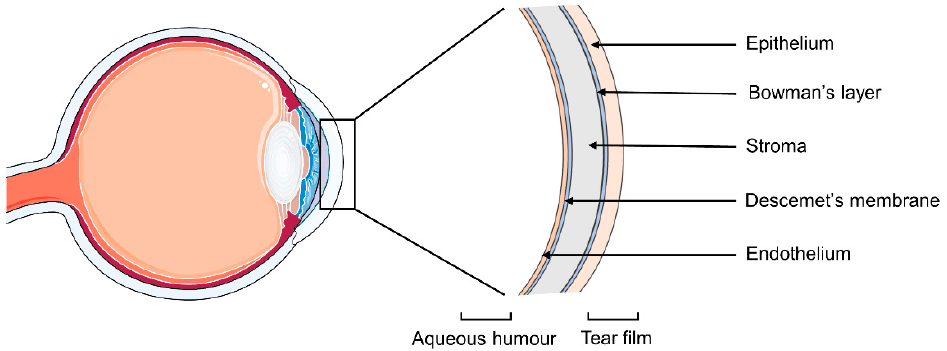
Figure 1. Schematic representation of the layers constituting the